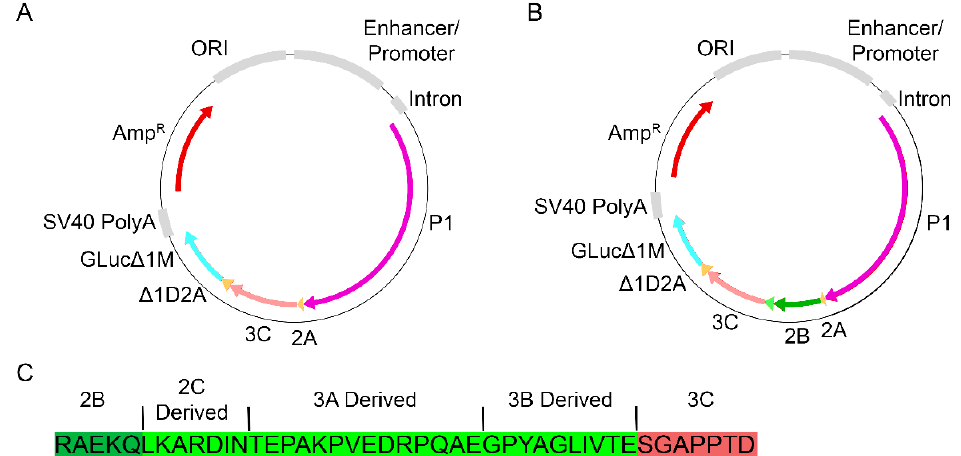
Figure 2. VLP-producing constructs expressed as a single polypeptide ( A ) P1, 2A, 3C, and the ∆ 1D2A-GLuc ∆ 1M reporter or ( B ) P1, 2A, 2B, 3C, and the ∆ 1D2A-GLuc ∆ 1M reporter. ( C ) Incorporation of 2B into the VLP construct mimicked previous Ad5 FMD vaccines containing 2B in addition to amino acids derived from 2C, 3A, and 3B.